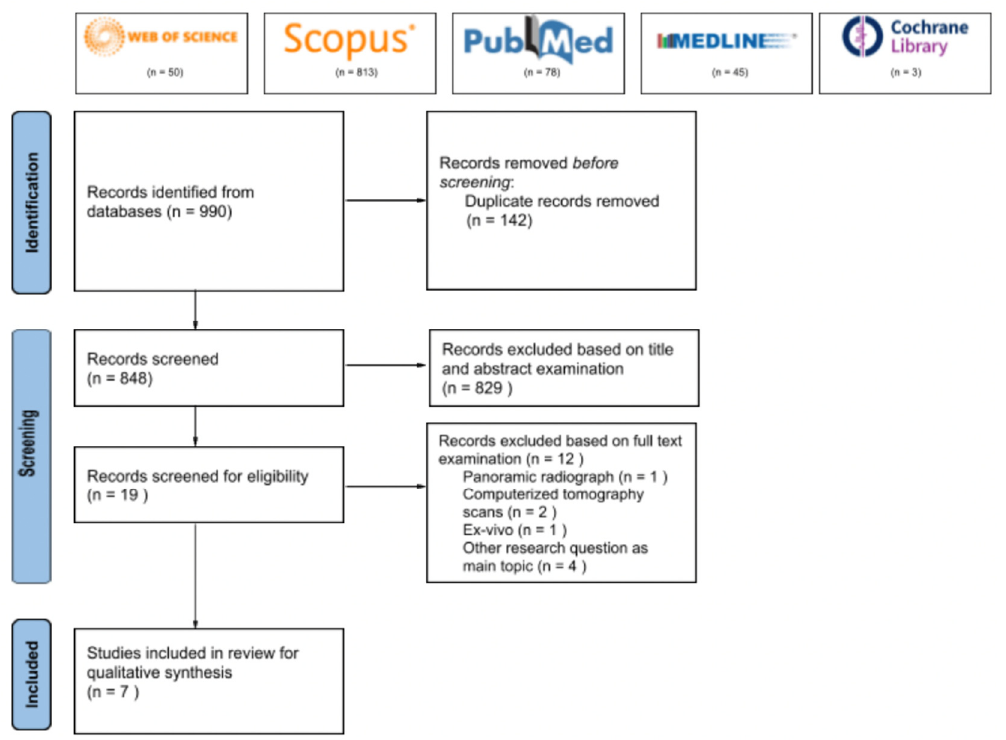
Figure 1. PRISMA flow diagram for the systematic reviews, which included searches of databases.